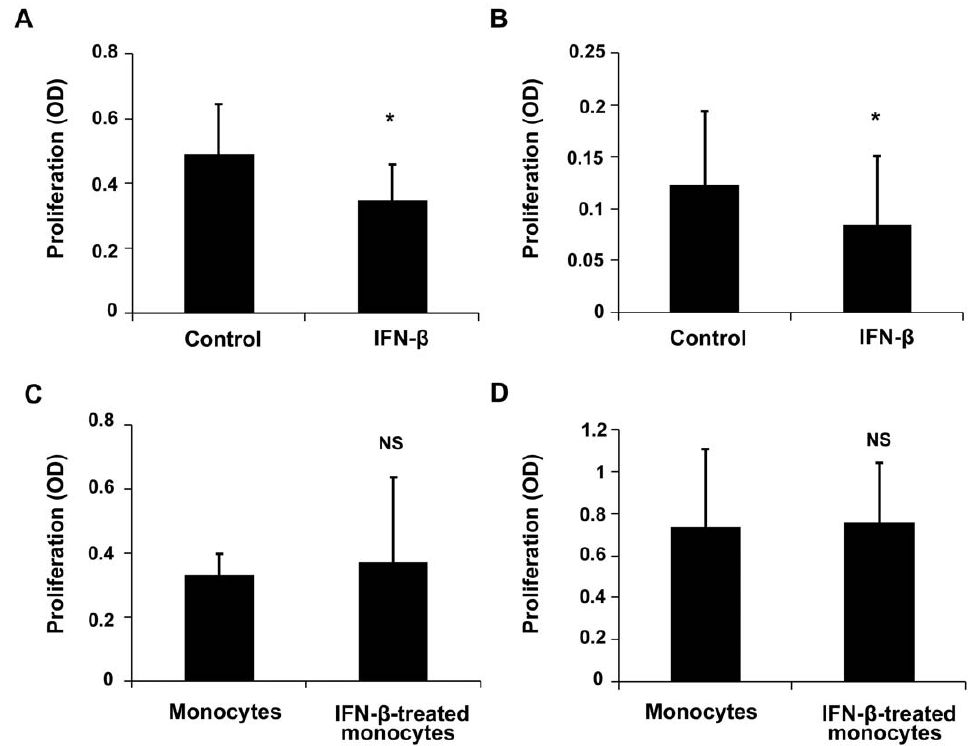
Figure 8. Effect of IFN- b on T cell proliferation. Naı¨ve T cells (A) or effector/memory T cells (B) from normal mice cultured with anti-CD3 (1 m g/ ml) and anti-CD28 (1 m g/ml) in the presence or absence IFN- b for 72 hours. IFN- b -treated monocytes cultured with naı¨ve T cells (C) or effector/ memory T cells (D) at a ratio of 1:5 for 72 hours. Proliferation was detected by modified MTT. Data are representative of three independent experiments with at least three mice per group. *p , 0.05, NS=not